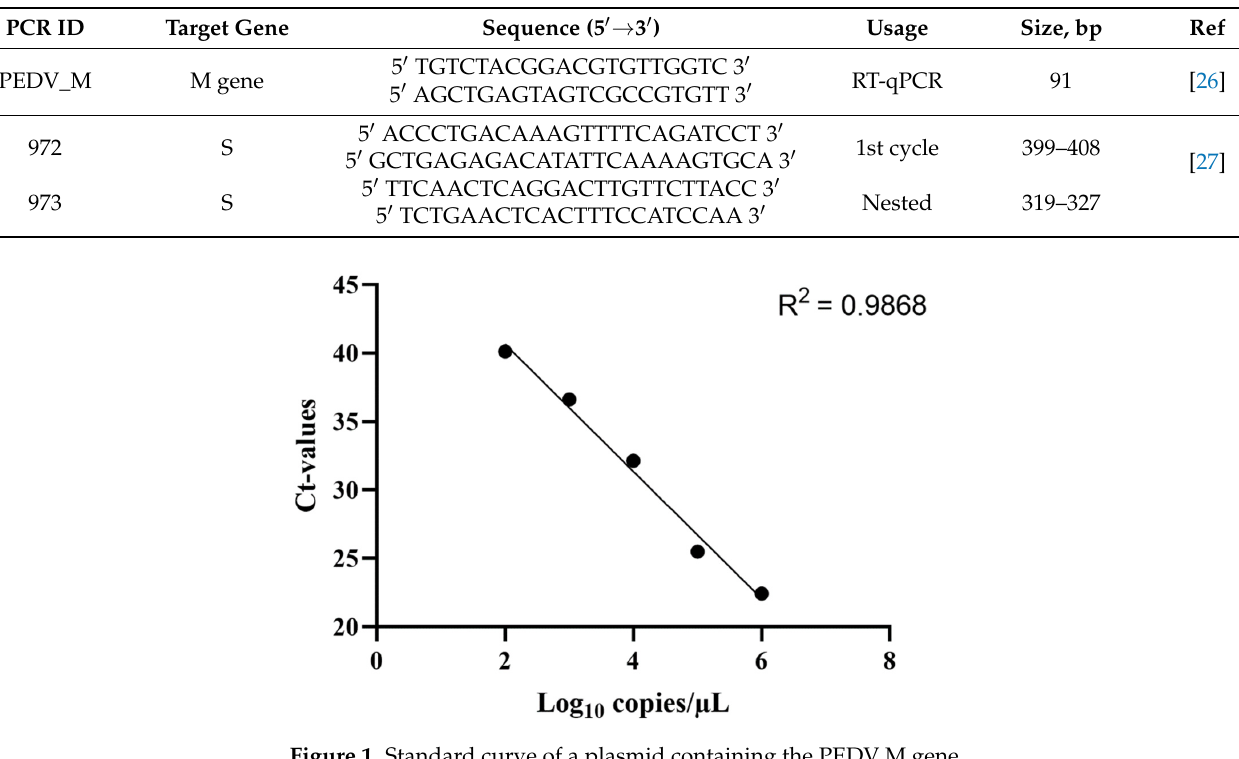
Figure 1. Standard curve of a plasmid containing the PEDV M gene